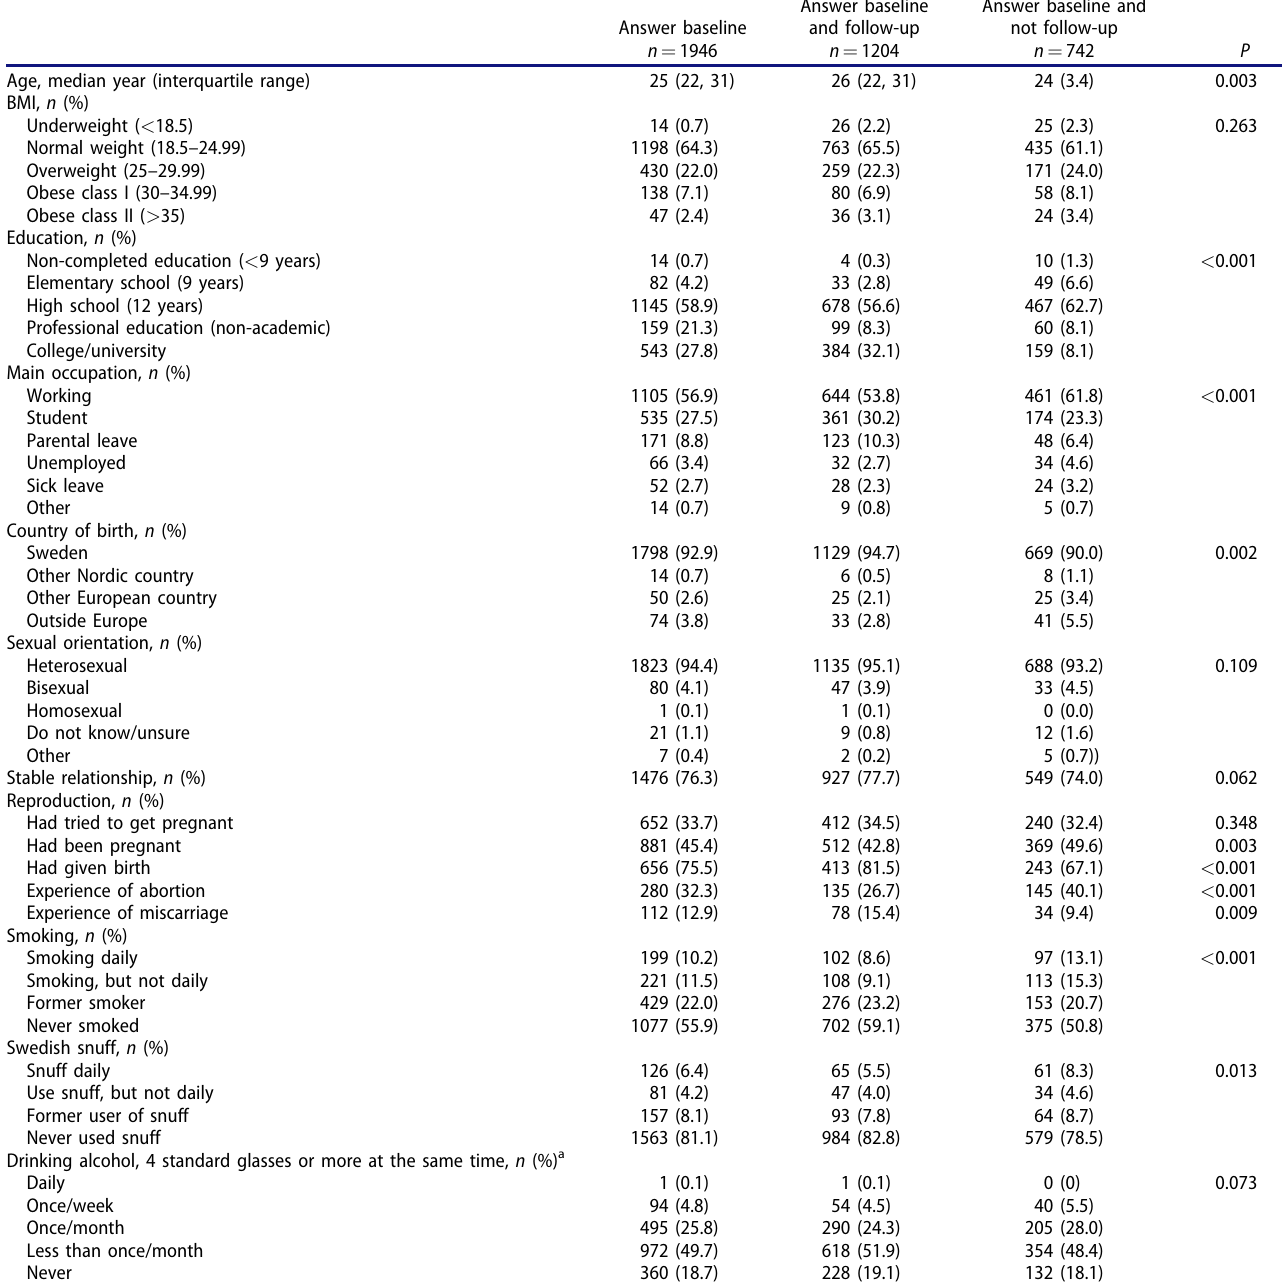
Table 1. Background and demographics among those who answered the baseline questionnaire and comparison between those who answered and did not answer the follow-up questionnaire.